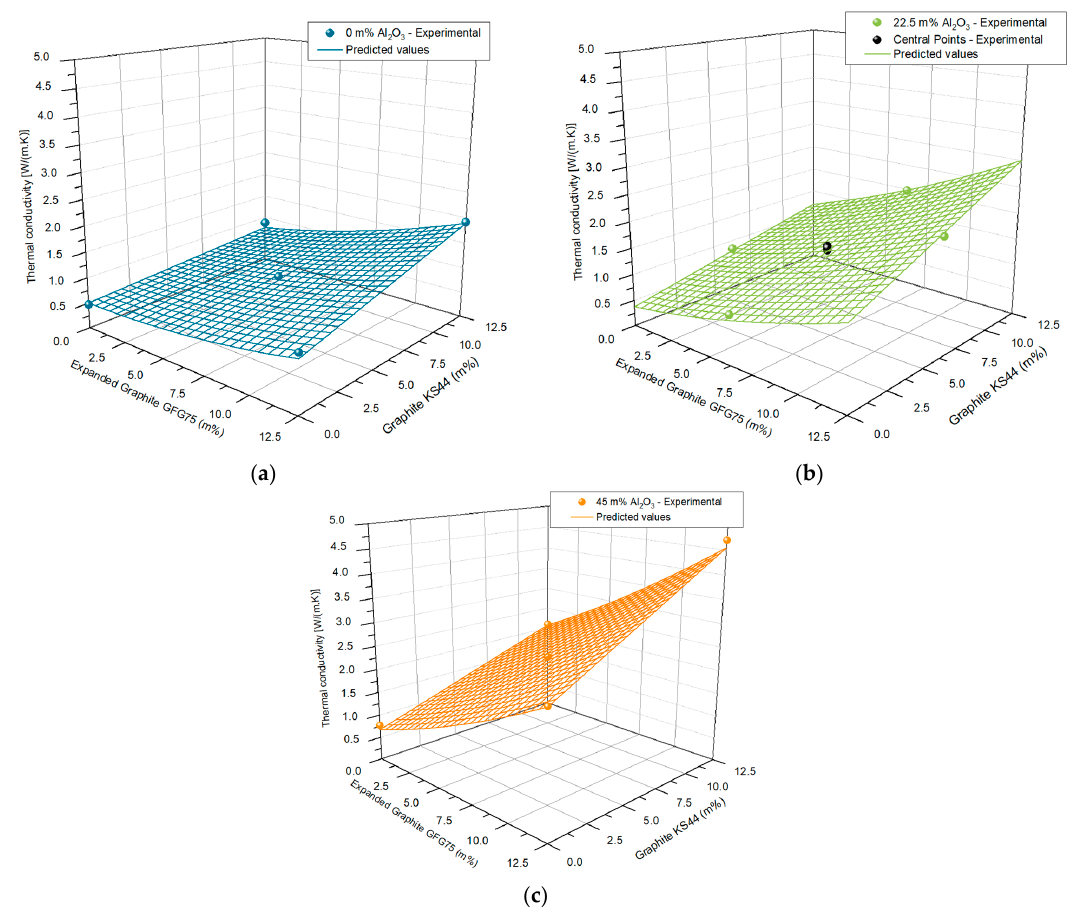
Figure 3. Response surface, in combination with the experimental data points for: ( a ) 0 m% Al 2 O 3 ; ( b ) 22,5 m% Al 2 O 3 ;( c ) 45 m% Al 2 O 3, respectively.